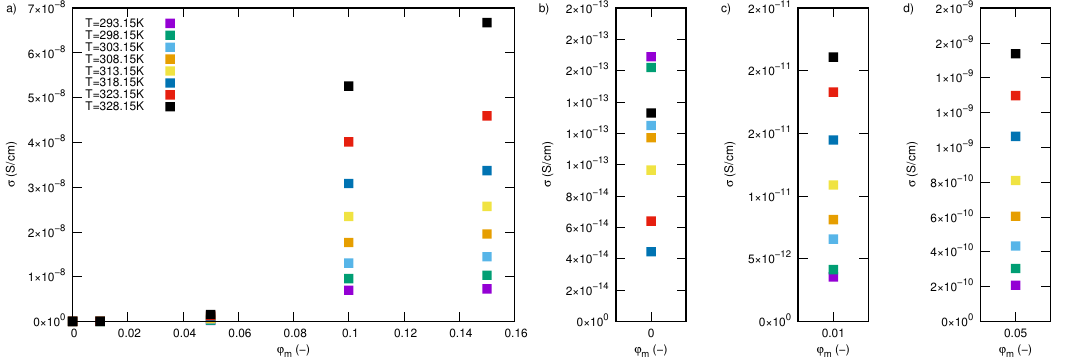
Figure 8. The dependence of the electrical conductivity at 0.1 Hz on the mass fraction of SiO 2 L nanoparticles: ( a ) in the entire mass fraction range, ( b ) the magnification for 0 mass fraction, ( c ) the magnification for 0.01 mass fraction, ( d ) the magnification for the 0.05 mass fraction.